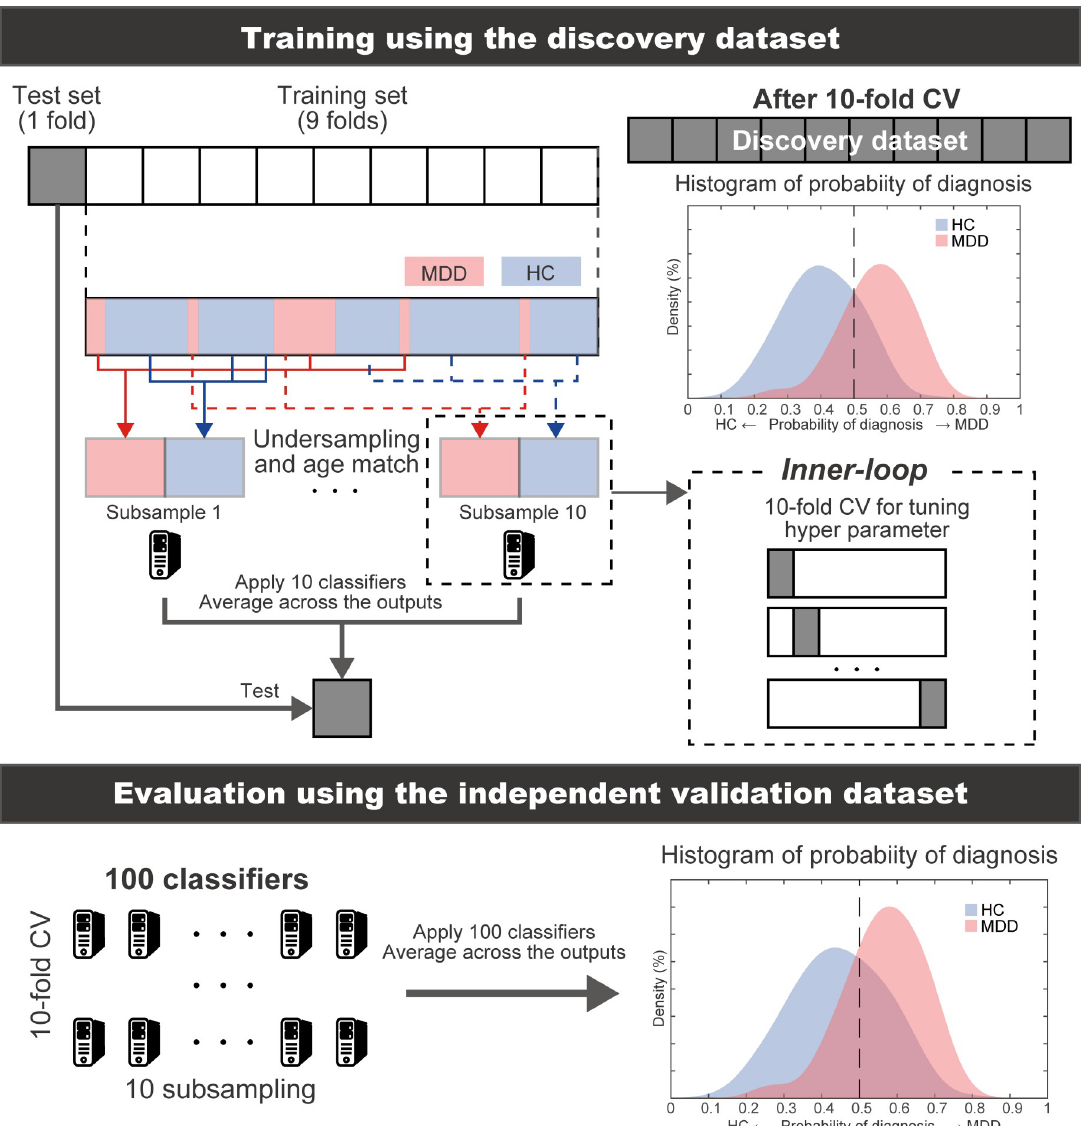
Fig 2. Schematic representation of the procedure for training the MDD classifier and evaluation of predictive power. The MDD classifier was constructed using a nested cross-validation procedure in the discovery dataset. We also used undersampling and subsampling techniques. Generalization performances were evaluated by applying the constructed classifiers to the independent validation dataset. The machine learning classifiers are represented by PC cartoons. CV, cross-validation; HC, healthy control; MDD, major depressive